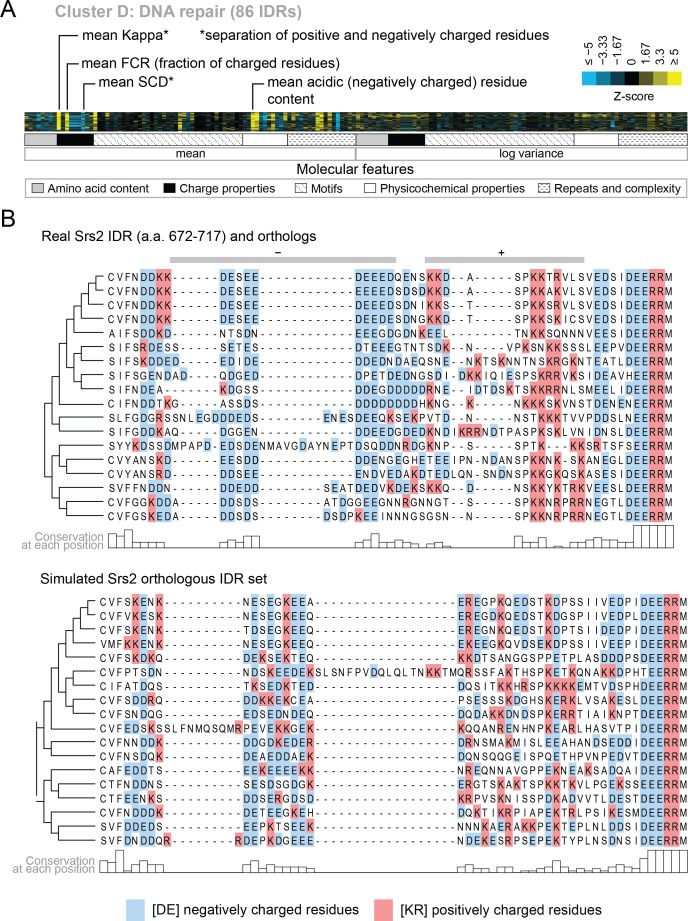
Cluster D contains disordered regions associated with DNA repair.(A) Pattern of evolutionary signatures in cluster D. (B) Example disordered region from cluster D, Srs2, with a subset of highlighted molecular features compared between its real set of orthologs and an example set of simulated orthologous IDRs. Species included in phylogeny in order from top to bottom are S. cerevisiae, S. mikatae, S. kudriavzevii, S. uvarum, C. glabrata, Kazachstania africana, K. naganishii, N. castellii, N. dairenensis, T. phaffii, Z. rouxii, T. delbrueckii, K. lactis, Eremothecium (Ashbya) gossypii, E. cymbalariae, Lachancea kluyveri, Lachancea thermotolerans, L. waltii.